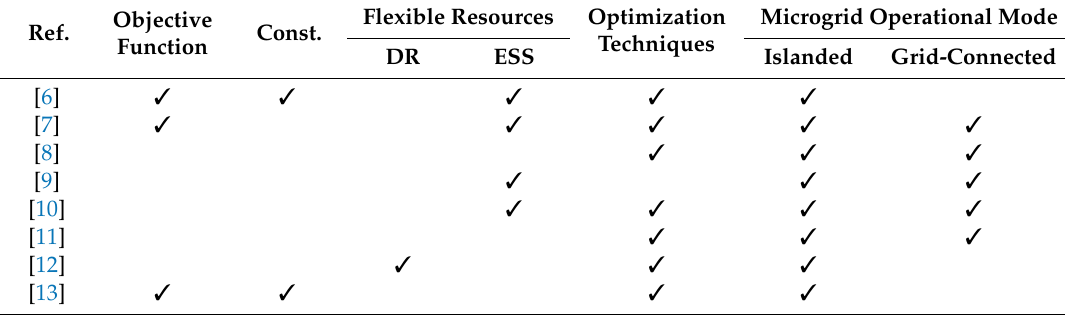
Table 1. A survey on the existing review papers of microgrid energy management system.